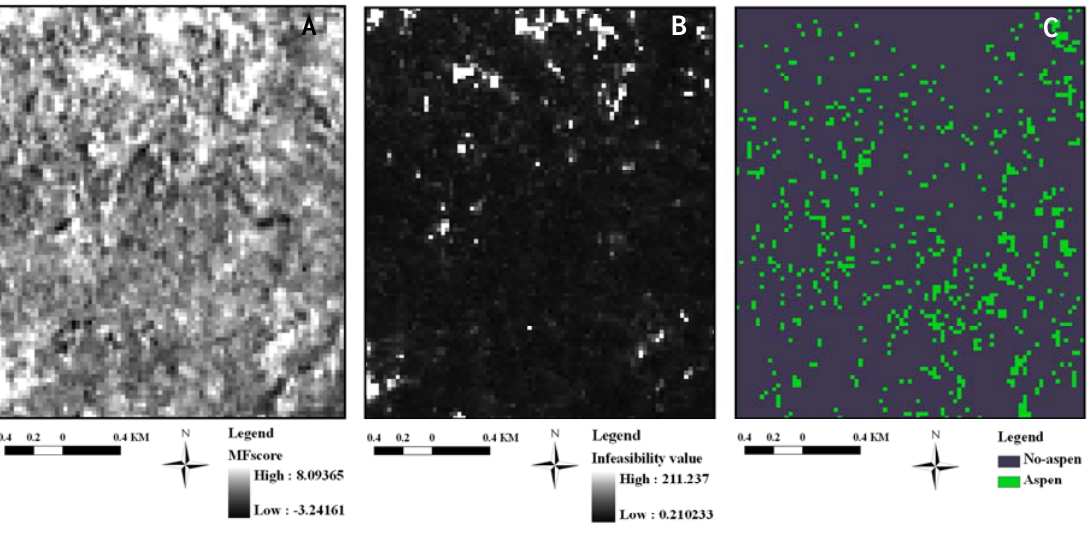
Figure 4. The Mixture Tuned Matched Filtering (MTMF) classification images and final aspen map for 2005. The image of matched filtering scores (a) estimates the abundance of target cover within each pixel, while the image of infeasibility values (b) indicates the relative accuracy of the matched filtering score in each pixel. Aspen presence and absence map (c) is produced after the regression integration of the two